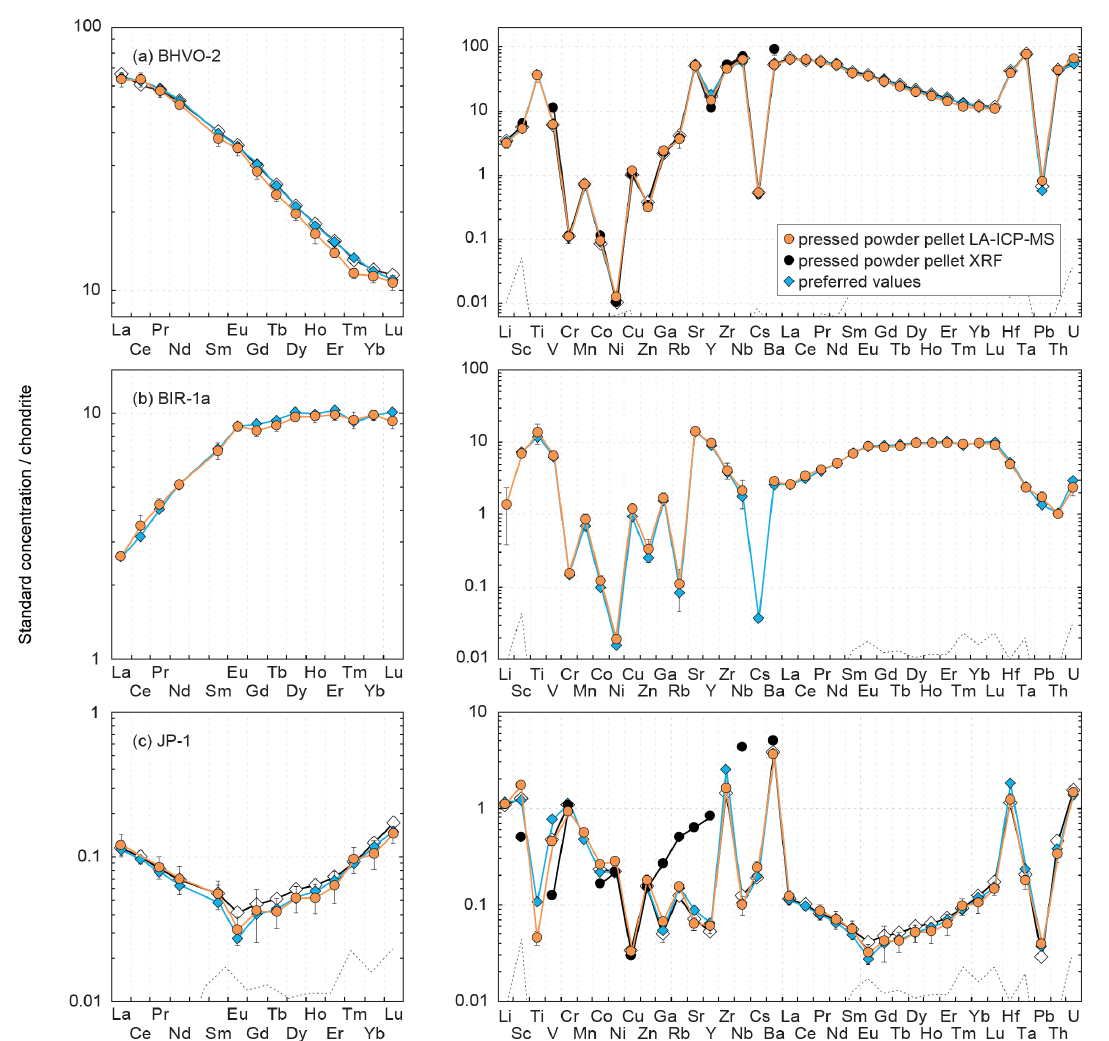
Figure 4. Chondrite-normalized (normalization values from Barrat et al., 2012) REE and multielement patterns obtained for the reference materials (a) BHVO-2, (b) BIR-1a and (c) JP-1 by LA-ICP-MS and XRF analyses of pressed powder pellets performed on-board the D/V Chikyu , compared to the preferred values. Preferred values are from the same references given in the Fig. 3 caption. Patterns obtained by Garbe-Schönberg and Müller (2014) for BHVO-2 and Peters and Pettke (2017) for JP-1 by the analysis of pressed powder pellets (prepared without a binder for BHVO-2, with a binder for JP-1) by LA-ICP-MS are also shown for comparison (white diamonds). The black dotted line represents the detection limit with the used instrumentation (values are given in Table